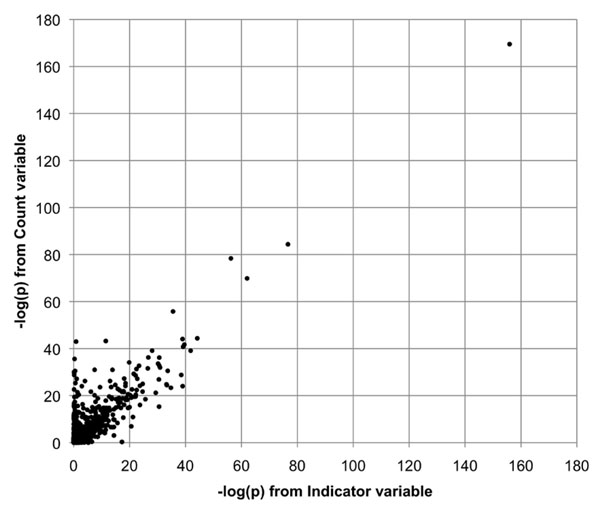
Comparison of Q1 results from two gene-wise collapsing methods for rare variants. Each data point represents the results of meta-analysis of a single gene using the first 50 data replicates. The horizontal position is −log(p) from the analysis based on the Indicator variable; the vertical position is based on the Count variable. The correlation between the two values is 0.92. If we eliminate the top four values, the correlation is still 0.86.